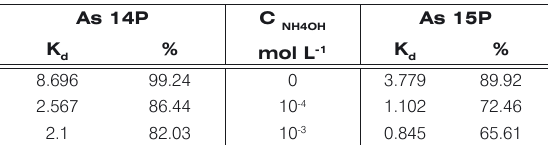
Table 3. Influence of NH OH concentration on Ag(I) sorption onto 4 As 14P and As 15P resin (m=0.1 g resin, C T=25°C, 24 hours contact time).